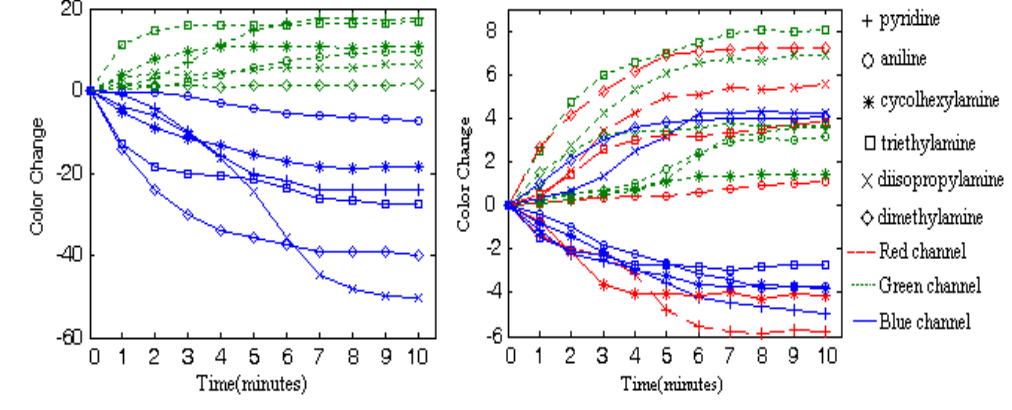
Figure 5. Representative responses for dye H2OEP (left) and dye CoTPP (right), showing the magnitudes of red, green and blue color changes over the course of 10 minutes exposure to the six amine headspace vapors. The response curves on the red channel for H2OEP gather in the zero neighboring area with a biggest magnitude of